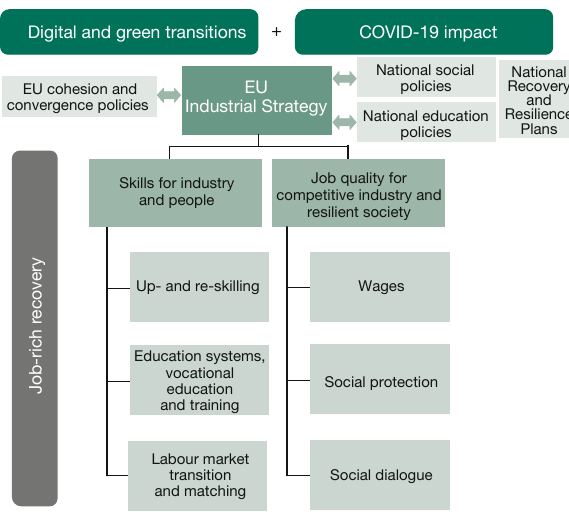
The social dimension of the EU industrial strategy